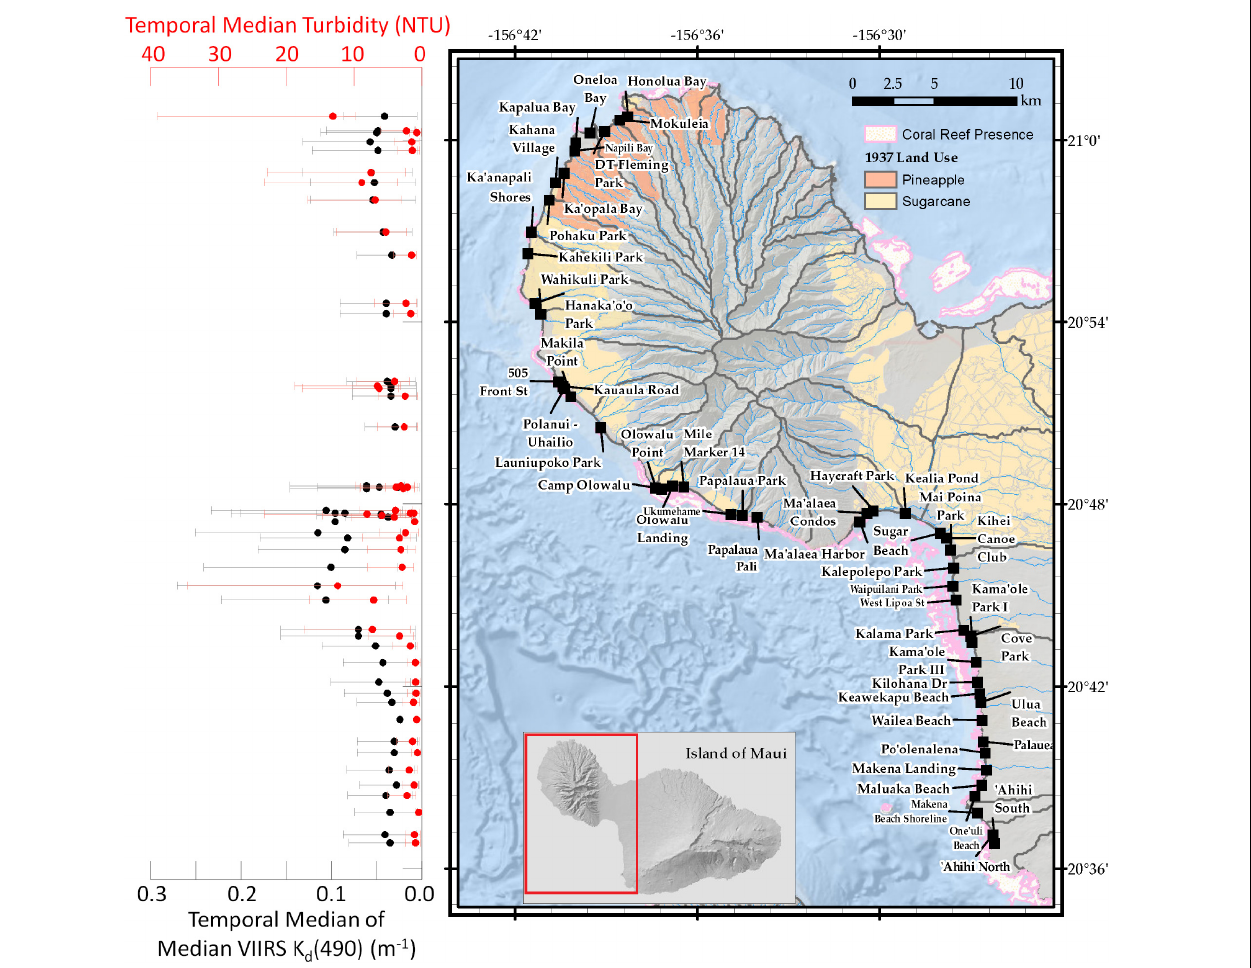
FIGURE 4 | (Left) Temporal median of the time series of (red, upper axis) in situ turbidity (NTU) and (black, lower axis) spatiotemporal (median of 5-pixels, 7-days cube) satellite K d (490) (m − 1 ) for each site by latitude in West Maui, HI. In situ turbidity measurements were taken using a Hach 2100Q turbidimeter. Data were included in the analysis only when in situ observations and satellite observations (in a 5-pixels, 7-days cube) were both available. Whiskers represent the 1st and 3rd quartiles of underlying time series data for each dataset, respectively. (Right) Map of collection sites along the West Maui coast. The 1937 land use layer shows areas historically used for pineapple (orange) and sugarcane (yellow) production. The pink with yellow pattern area shows coral reef presence along the